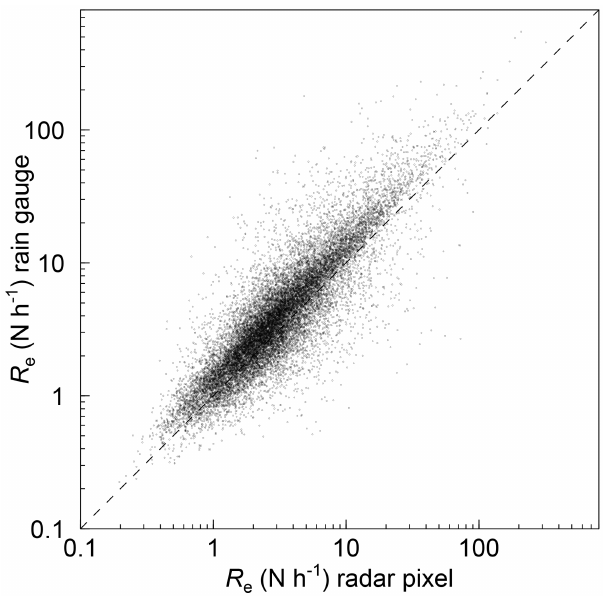
Figure 5. Comparison of event erosivity R e calculated from radar data and R e from rain gauge data for 115 radar pixels that enclose a rain gauge. Only events that were erosive at both scales (19944 events) during the 16-year period are shown. The dashed line repre- sents unity. Axes are log-scaled. Note that no spatial scaling factor or method factor was applied because these factors also included the effect of incomplete coverage of the pixel by an erosive rain